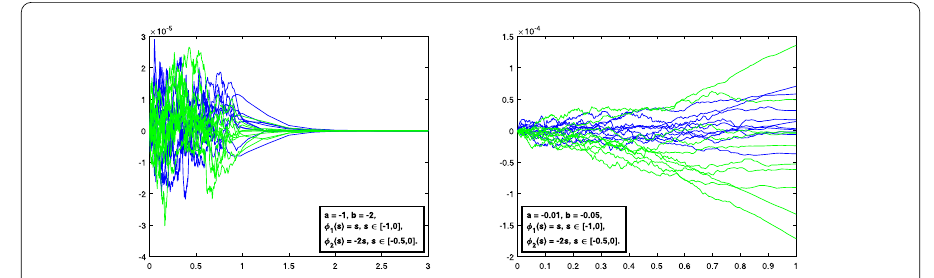
Figure 11 Ten stable and unstable (unbounded) trajectories for each process x 1 ( t ) and x 2 ( t ) of the solution of (38)